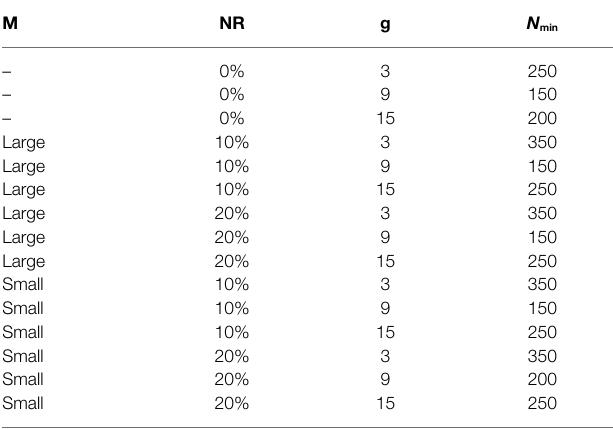
TABLE 3 | Minimal group sizes required for alignment when magnitudes of noninvariance and noninvariance rates are different. M NR g N